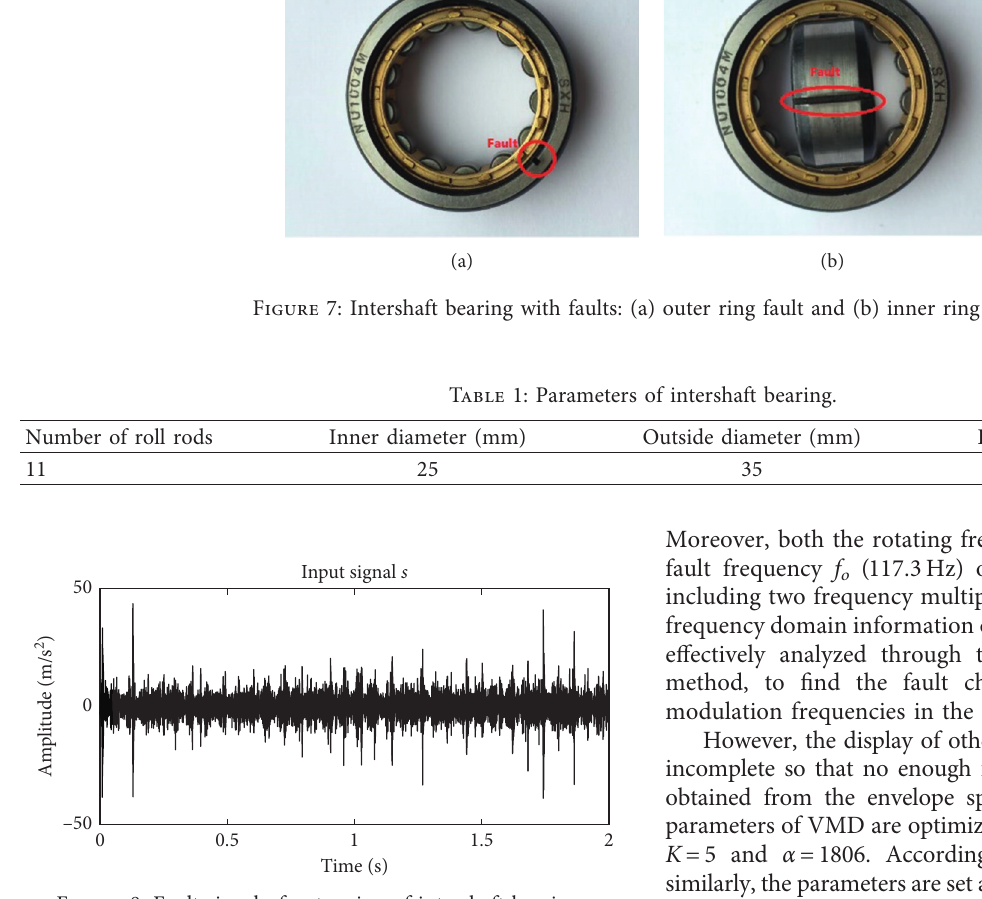
Figure 8: Fault signal of outer ring of intershaft bearing.